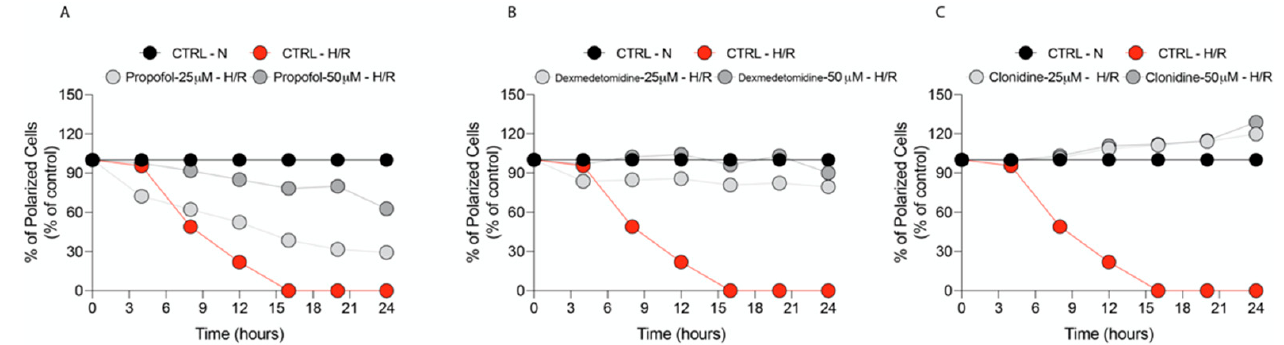
Figure 2. Real-time analysis of ΔΨ m modification. JC-1 accumulates in mitochondria as a function of Δψ is excited at 490 nm, and emits at 527 nm when in monomeric form. At high Δψ , JC-1 is concentrated within mitochondria and forms J aggregates, resulting in a shift in emission to 585 nm. Real-time analysis of ΔΨ m modification monitoring by Operetta Hugh Content Screening following treatment with ( A ) Propofol, ( B ) Dexmedetomidine, and ( C ) Clonidine. Results are presented as the mean ± SD of four independent experiments.